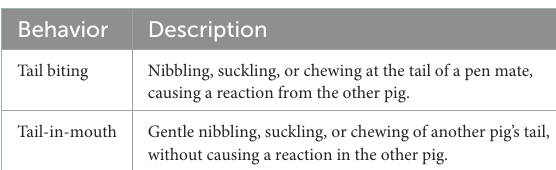
TABLE 1 Ethogram of biting behavior in piglets, adapted from Hakansson and Bolhuis